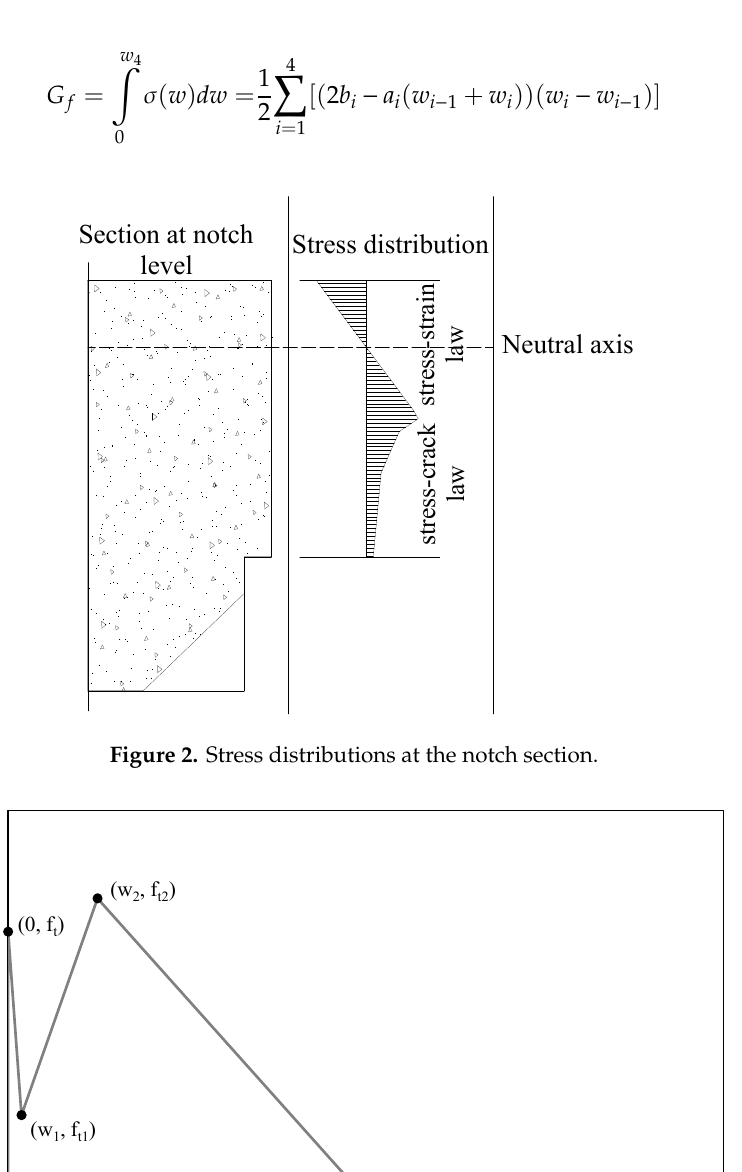
Figure 3. Quadrilinear stress–crack opening relationship.